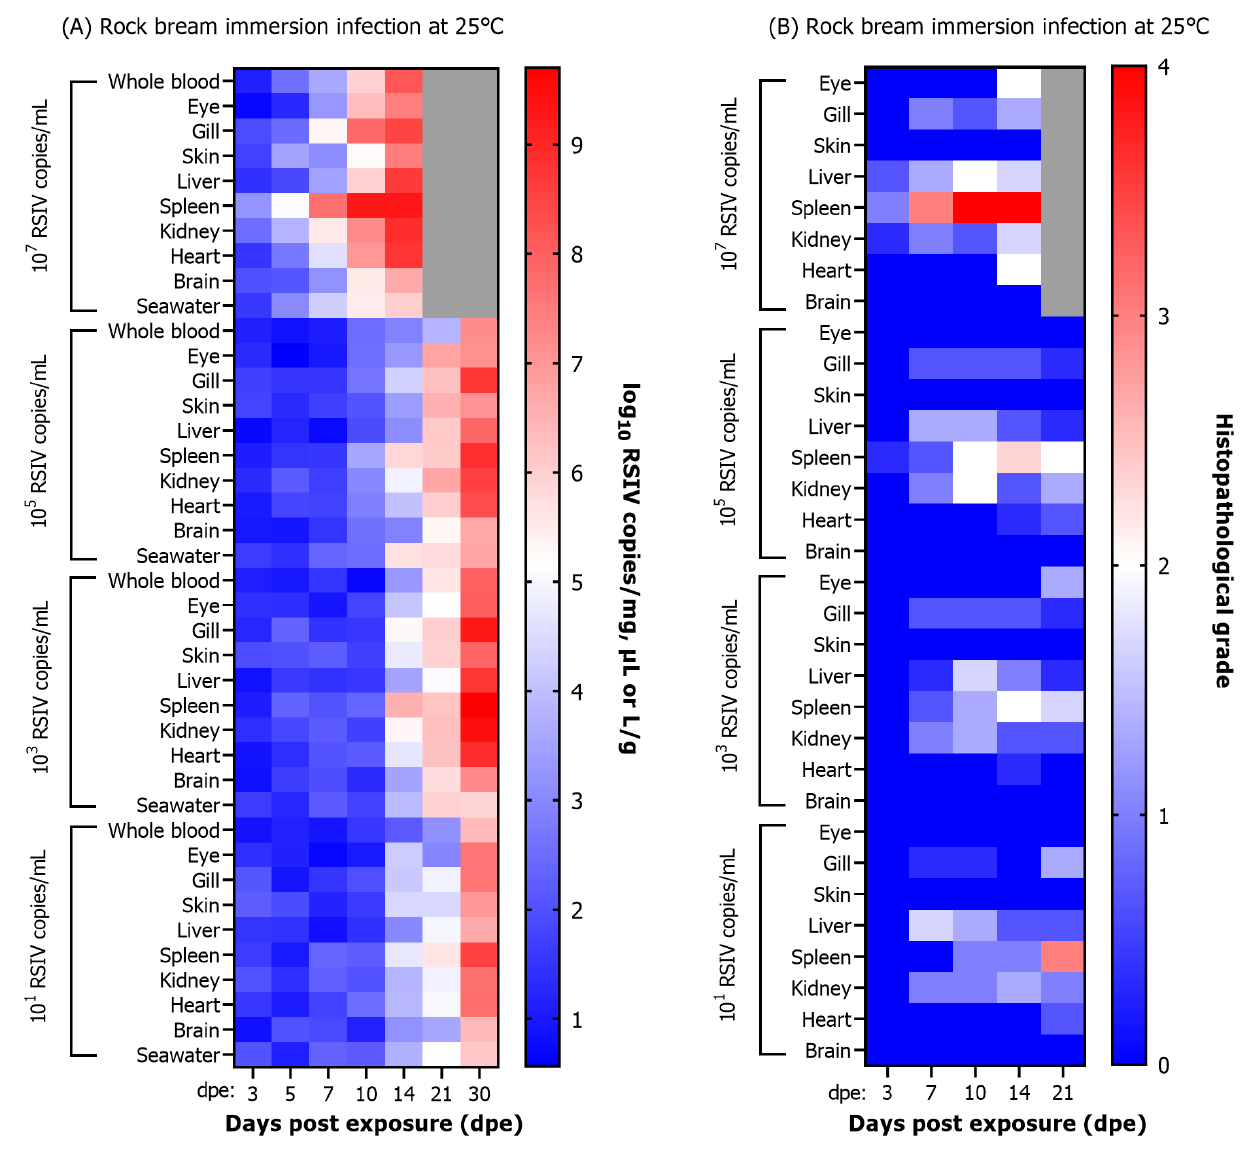
Figure 4. ( A ) Viral load and ( B ) histopathological grade results after immersion exposure with red sea bream iridovirus (RSIV) at four concentrations (final concentrations 10 7 , 10 5 , 10 3 , and 10 1 RSIV copies/mL) in rock bream ( Oplegnathus fasciatus ) at 25 °C. The box represents the average of three fish, and an analysis was not performed because all fish died due to RSIV infection, as seen in the gray box ( A , B ).